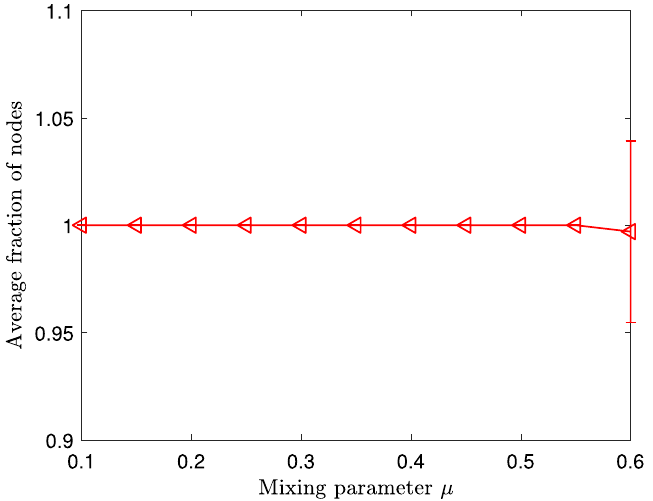
Figure 1. Average fraction of nodes in the chosen local cluster that is also in the sampled subgraph in the Lancichinetti–Fortunato–Radicchi benchmark. Vertical error bars represent standard deviations.